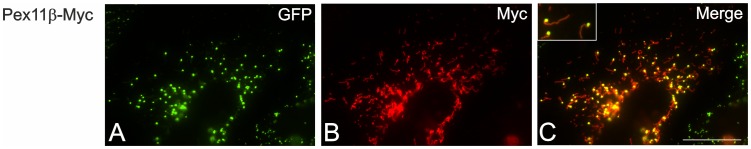
Pex11pβ-induced peroxisomal division is impaired under lipid-free culture conditions.COS-7 cells stably expressing a GFP-PTS1 fusion protein targeted to peroxisomes were incubated in lipid-free Panserin™ medium and transfected with Pex11pβ-Myc. Cells were processed for immunofluorescence using anti-Myc. Bar, 20 µm.